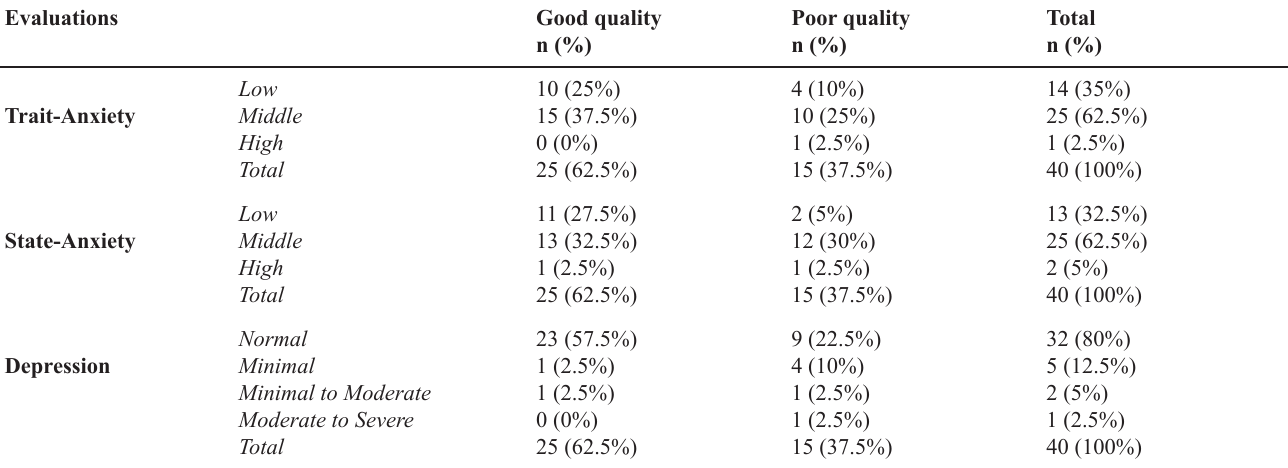
Table 3. Associations of trait and state-anxiety and depression with good or poor sleep quality.